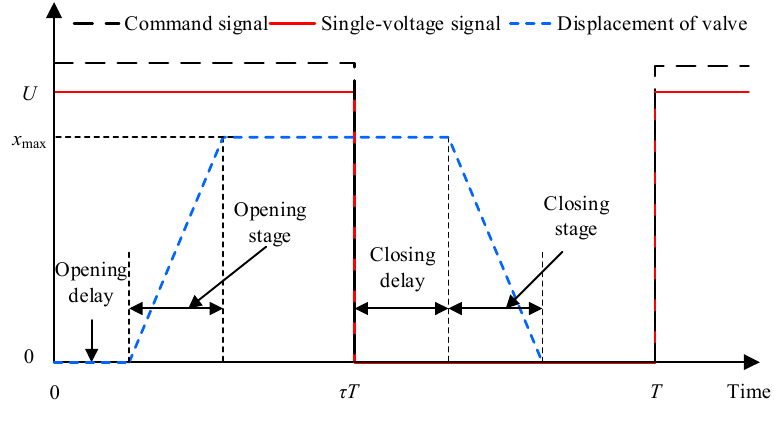
Figure 4. Diagram of single-voltage control signal.